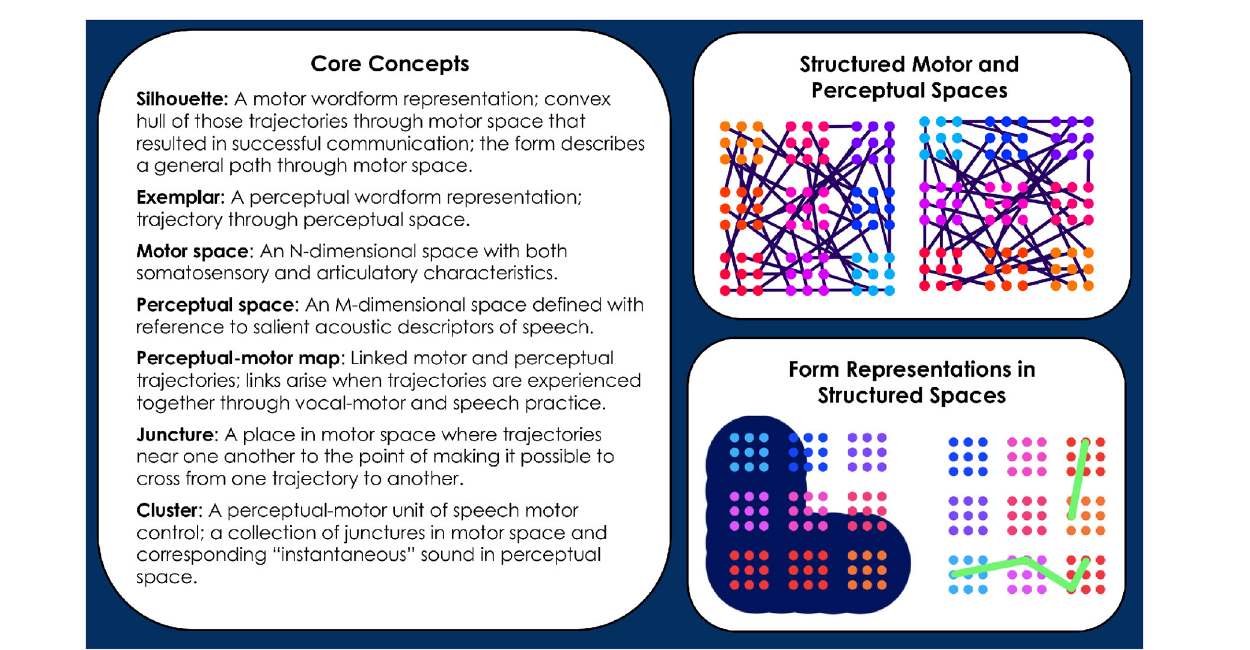
FIGURE1 Informal definitions of Core concepts are provided (see text for detail). The illustrations to the right of the definitions depict several of the concepts. The top right panel depicts 2-dimensional motor (left) and perceptual (right) spaces that have already been structured by the trajectory crossings that occur with vocal-motor exploration and speech practice. Junctures are represented as dots, clusters as groups of identically colored dots. Each cluster of a particular color in motor space corresponds to one of the same color in perceptual space. Links between the motor and perceptual spaces are assumed but not shown. The bottom right panel depicts a silhouette (left) and an exemplar (right) in relation to the motor and perceptual spaces, respectively. The depiction of the silhouette highlights the idea that it describes a broad path through motor space. The depiction of an exemplar highlights its status as a specific trajectory through perceptual space. The distinct layouts of clusters in the simplified motor and perceptual spaces illustrates that these spaces have different